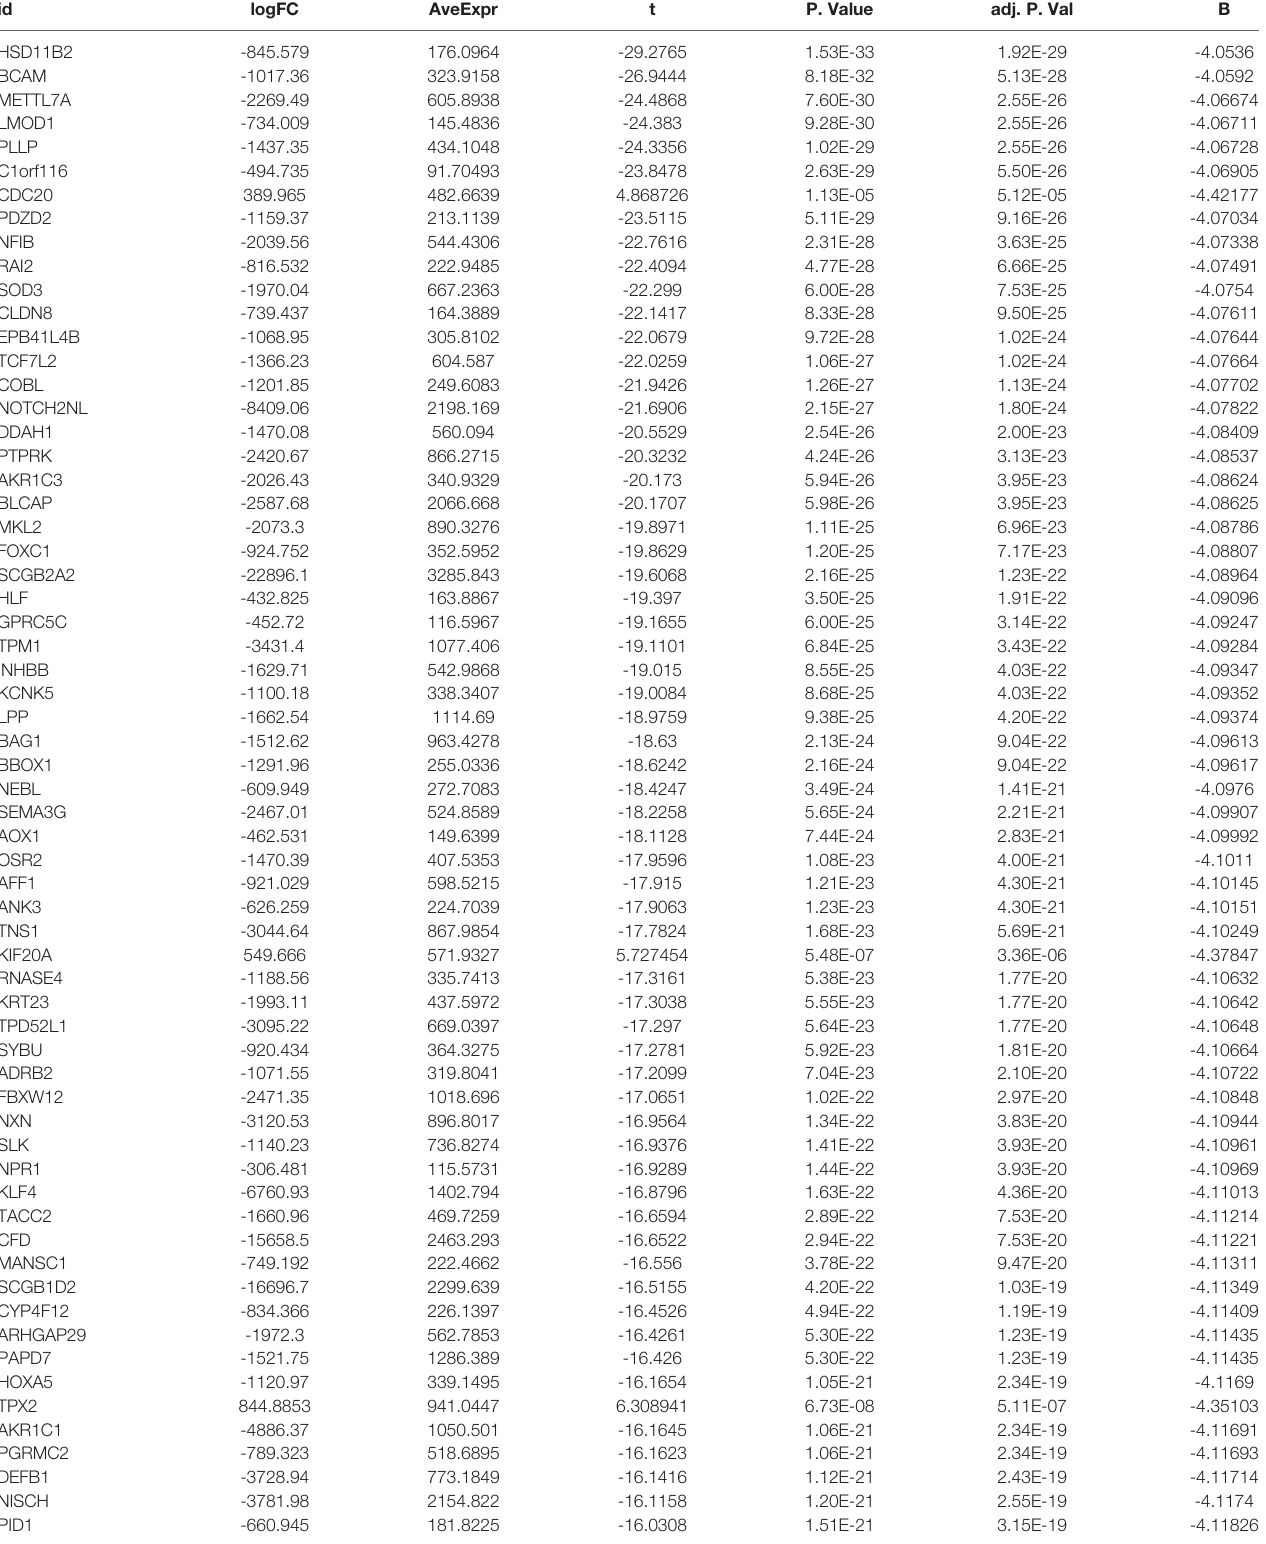
TABLE 1 | Top 100 differentially expressed genes from UCSC Xena database differential expression